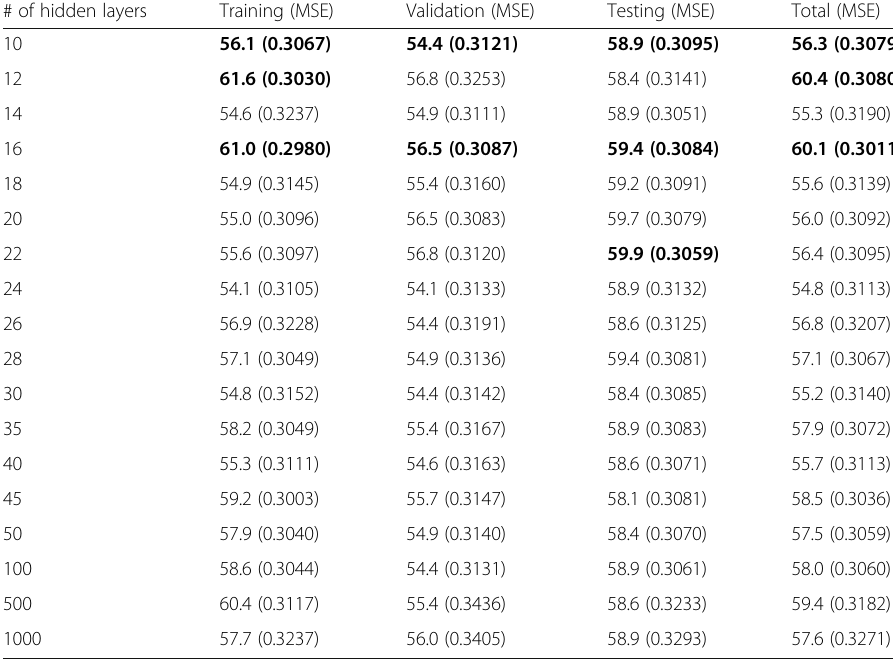
Table 4 Classification results with ANN/DNN classifiers using transformed data with PCs = 31 # of hidden